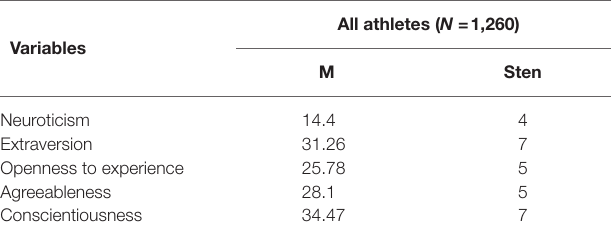
TABLE 1 | Analysis of the mean and sten values of the studied athlete population according to personality traits. Variables